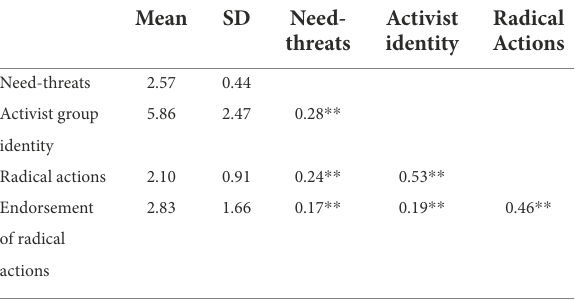
TABLE 1 Means, standard deviations, and correlations for all